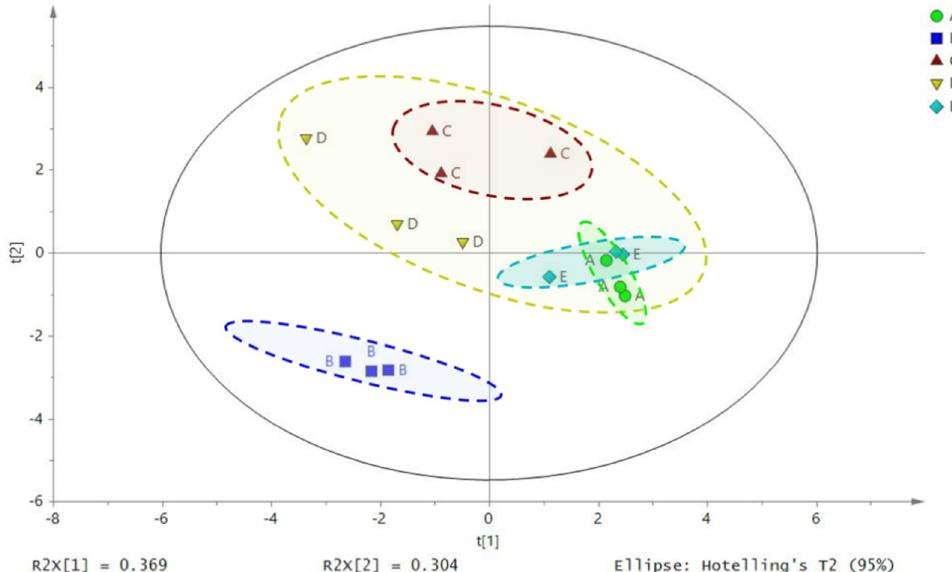
Fig. 9 Principal component analysis of the fatty acid content of winter jujube in different groups. A nonmechanical injury group; B mechanical injury group; C gray mold-inoculated group; D 2EC 50 surfactin; E 8EC 50